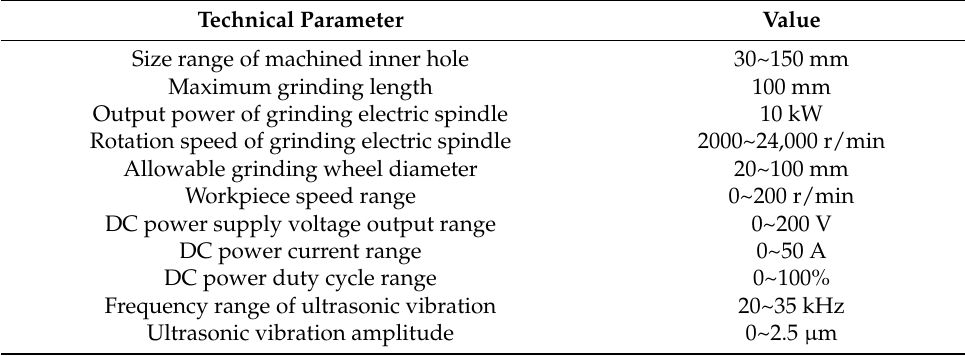
Table 1. Main technical parameters of the special machine tool for ICUAECG.